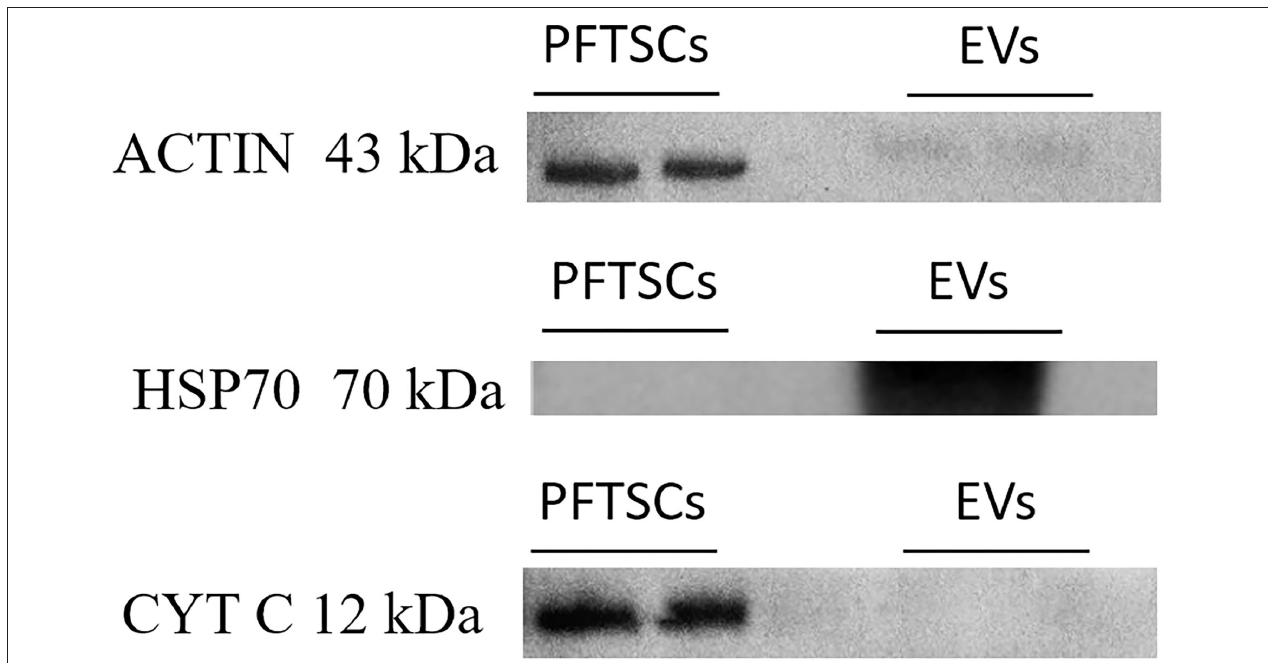
FIGURE 3 | The characterization and differences between PFTSCs and collected EVs. The experiment was demonstrated by Western blotting (repeated thrice).